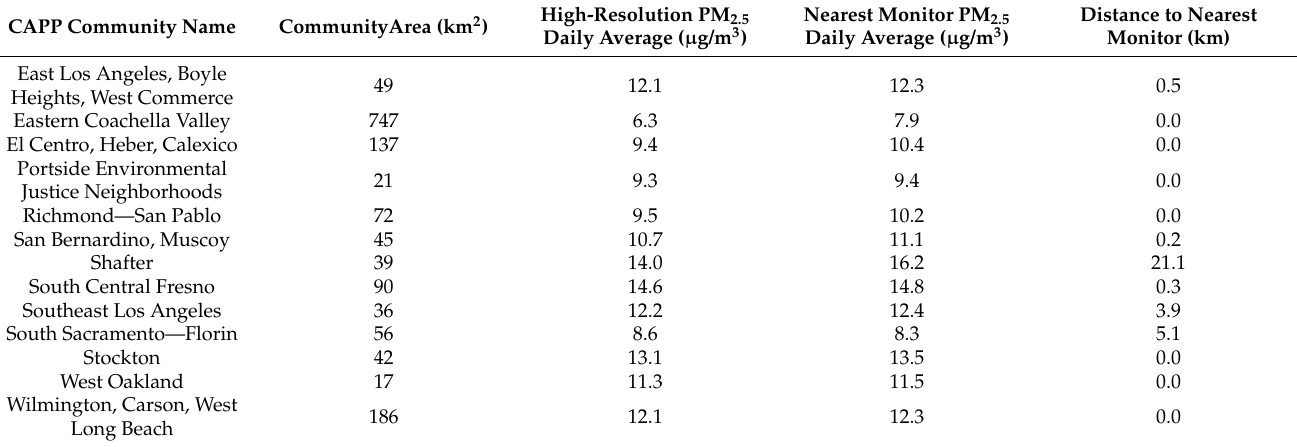
Table 1. PM 2.5 daily averages (2015–2018) and summary information for CAPP communities. Com- munity area concentrations were derived from satellite-based estimates at a 1 km 2 horizontal spatial resolution and were corrected for model error using nearest monitor data. Nearest monitor concen- trations are based on regulatory ground monitoring stations. Community areas and distance to the nearest monitor, based on the nearest community boundary, were calculated in ArcMAP; monitors located within community boundaries have a distance of